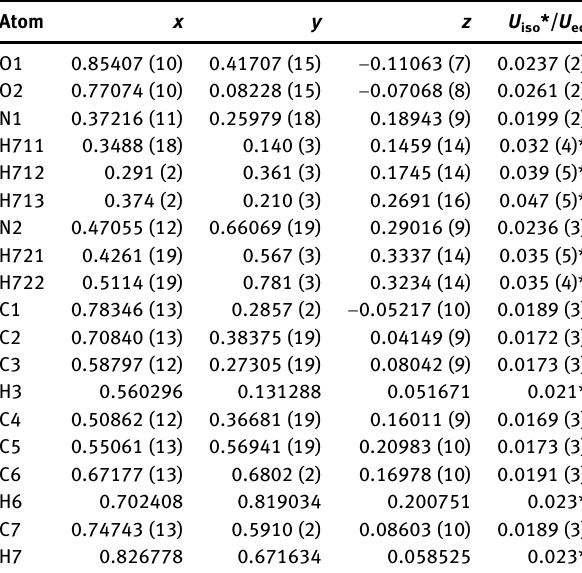
Table  : Fractional atomic coordinates and isotropic or equivalent isotropic displacement parameters (Å  ).